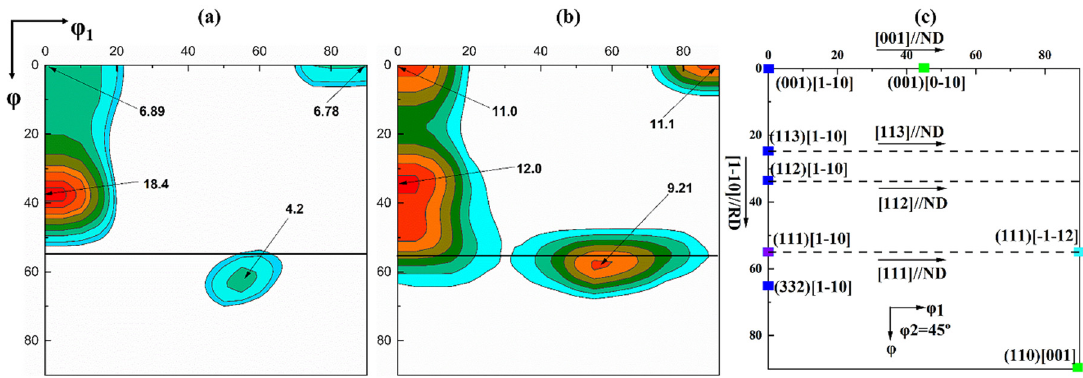
Figure 5. The φ 2 = 45° section of the orientation distribution function (ODF) obtained from electron backscatter diffraction (EBSD) after cold rolling. ( a ) SR; ( b ) ASR; ( c ) typical texture components and orientation rotation path displayed in the φ 2 = 45° section of the ODF.